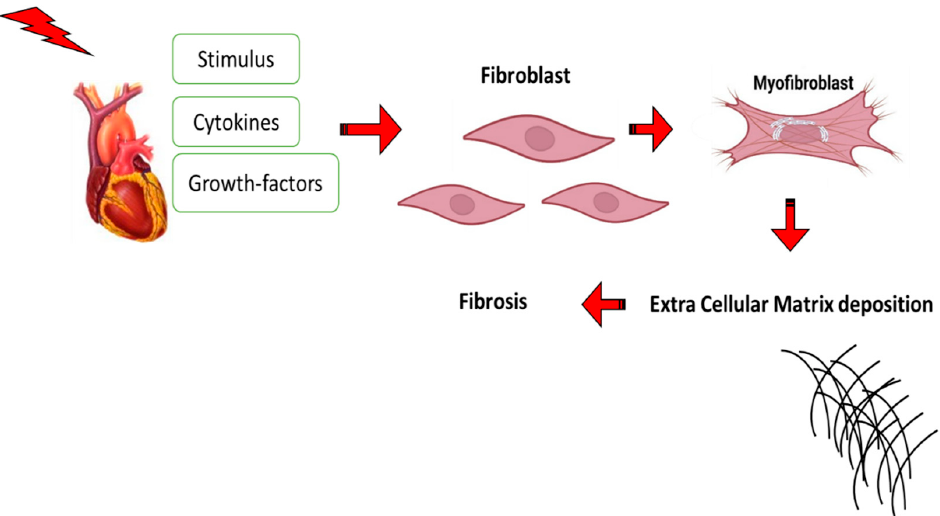
Figure 12. The diagram illustrates cardiac fibrosis; the stimulus encourages the release of cytokines and growth factors, the differentiation of fibroblasts to myofibroblasts, and the deposition of the extracellular matrix.